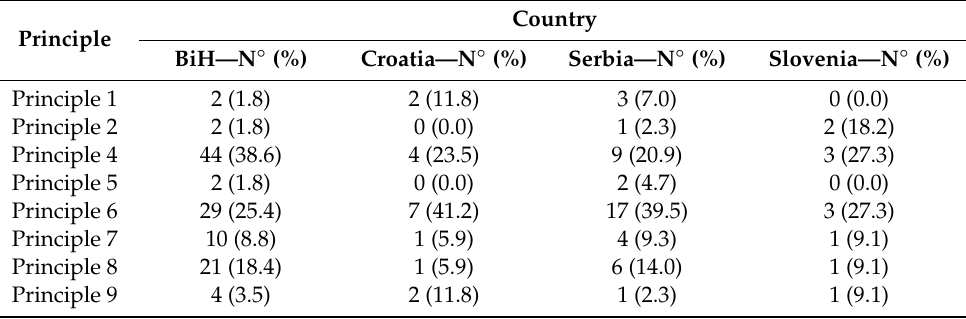
Table 6. The number and distribution of non-conformities by FSC principles and